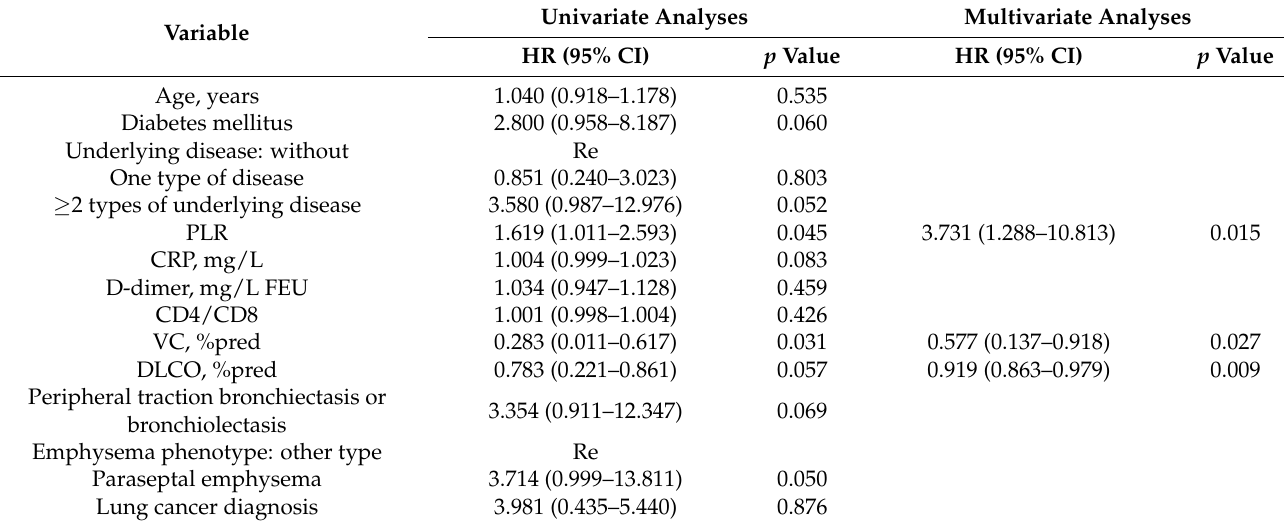
Table 6. Risk factors for AE in patients with